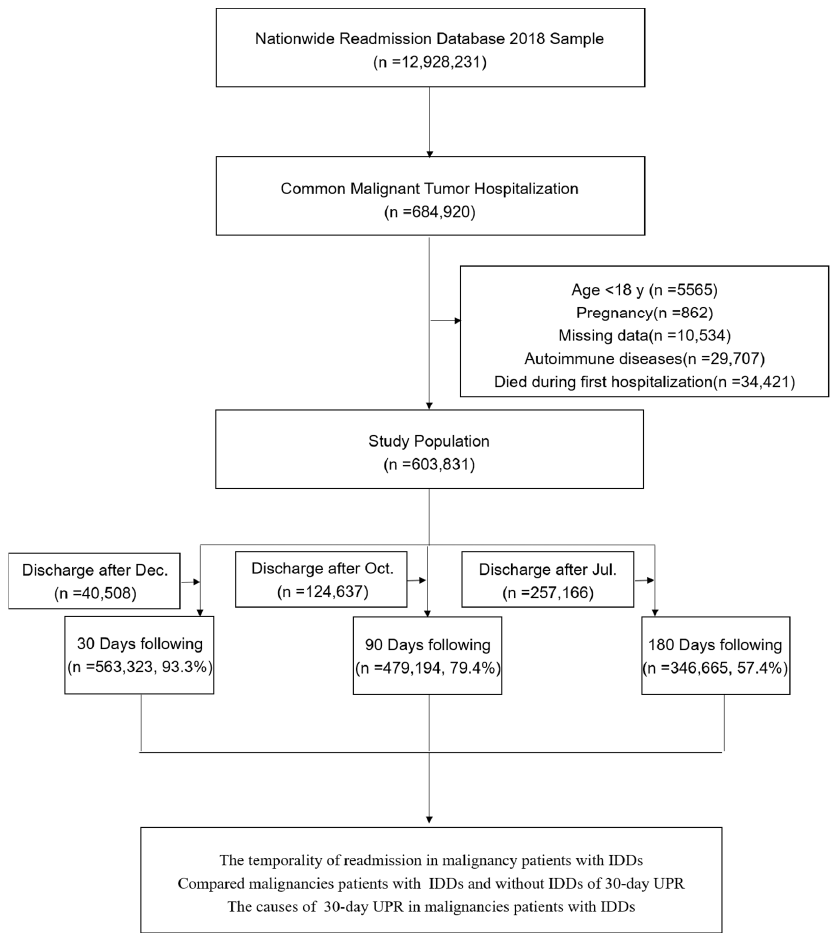
Figure 1. Inclusion and exclusion